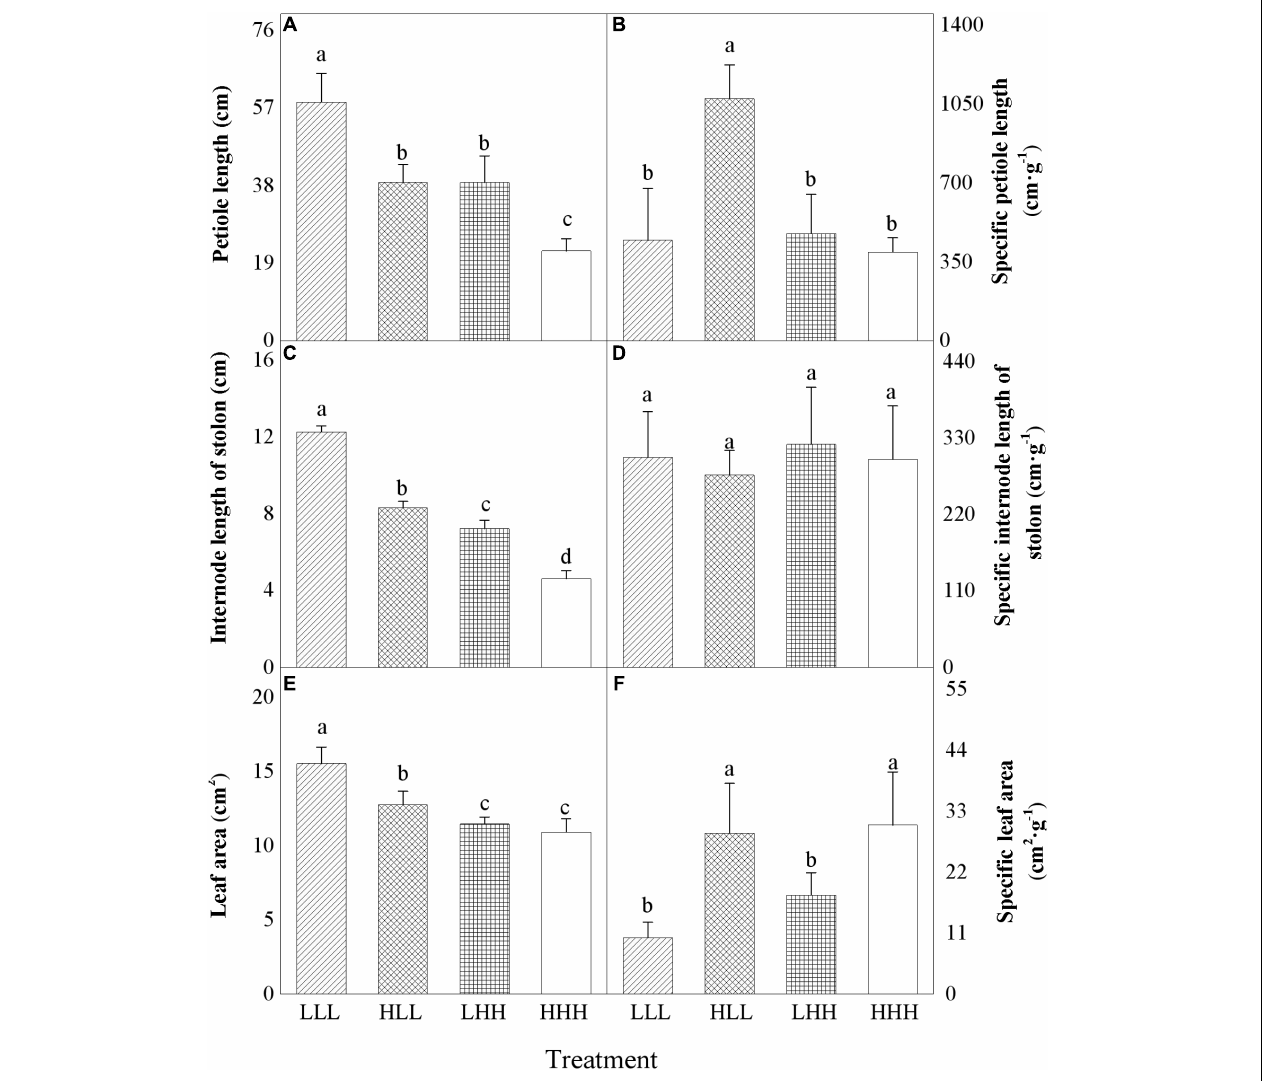
FIGURE 2 | Effects of transgenerational plasticity on morphological properties of offspring ranets (F 2 generations). The same lower case letters are not significantly different at the P = 0.05 level. Values are means ± s.e. (standard errors), n = 8. HHH: F 0 generation high light + F 1 generation high light + F 2 generation high light; HLL: F 0 generation high light + F 1 generation low light + F 2 generation low light; LHH: F 0 generation low light + F 1 generation high light+ F 2 generation high light; LLL: